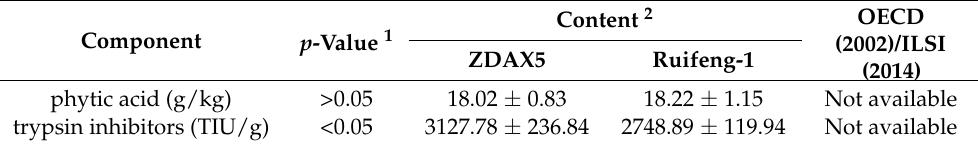
Component Table 6. Anti-nutrient levels in ZDAX5 maize grain and Ruifeng-1 maize grain.